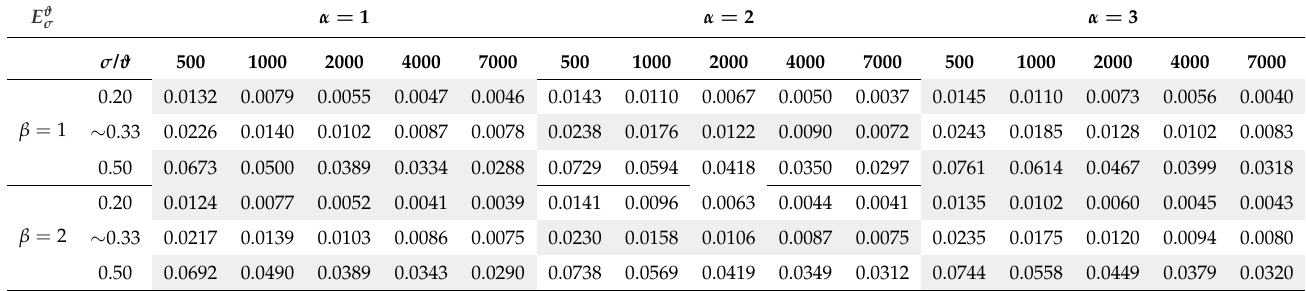
Figure 7. DFN158. Example for the case ( α = 2, β = 2 ) . Plot of the function (cid:98) E ( σ , ϑ ) and the data points E ϑ σ (red stars). Table 3. DFN395. Table of the E ϑ σ values, varying ( σ , ϑ ) ∈ Σ × Θ , for each NN of architecture A α trained with configuration β , for each α = 1,2,3, and for each β = 1,2.